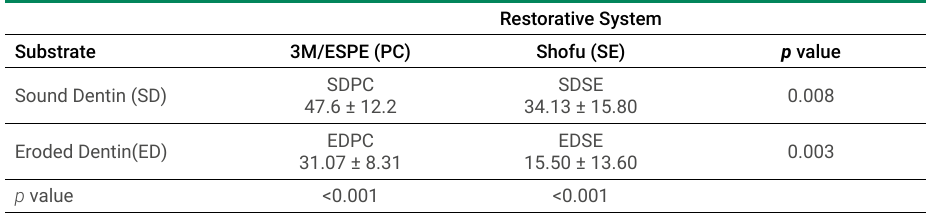
Table 2. Microtensile bond strength (MPa) values and standard deviation of each experimental group. Restorative